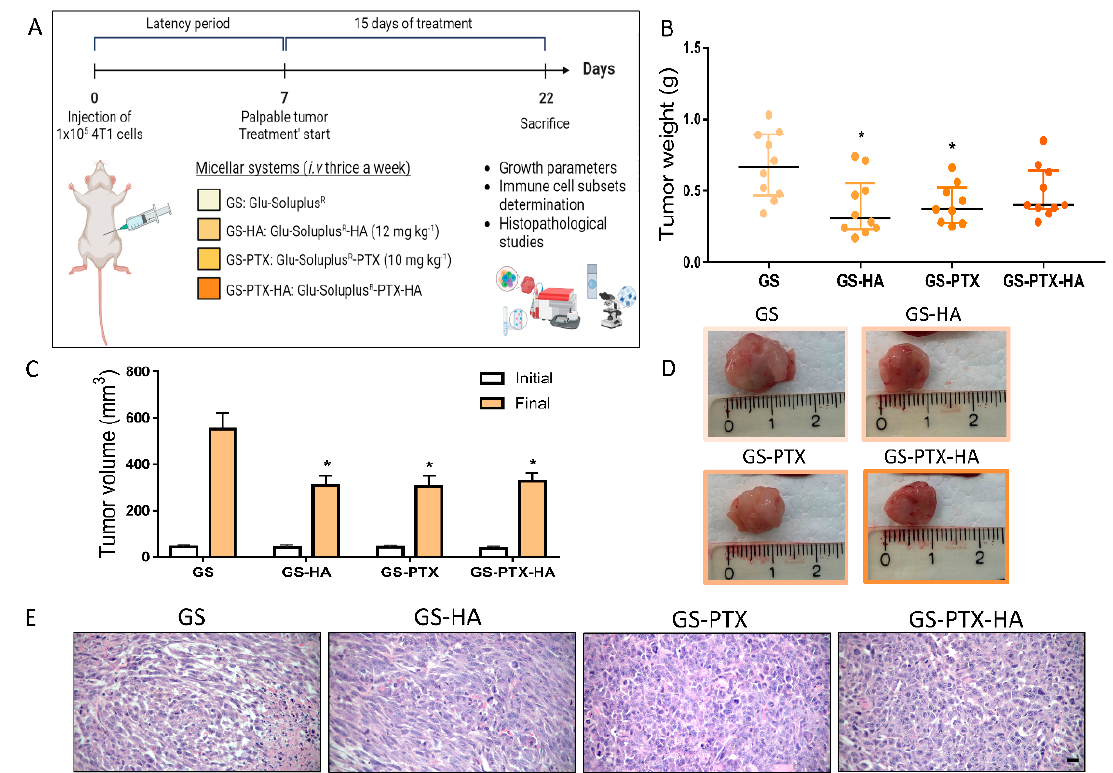
Figure 6. In vivo antitumor effects of glycosylated nanomicellar formulations. ( A ) Experimental design. Eight-week-old female mice with an average weight of 20–25 g were used for all experimental groups ( n = 9–10). Figure created with BioRender.com. ( B ) Tumor weight. ( C ) Initial and final tumor volume. ( D ) Representative images of fresh tumors. ( E ) Representative images of tumor samples stained with H&E. ×400 original magnification. Scale bar = 20 µm. Scatter dot plots represent the median and interquartile range. ANOVA and Tukey’s multiple comparisons test, * p < 0.05 vs. GS.